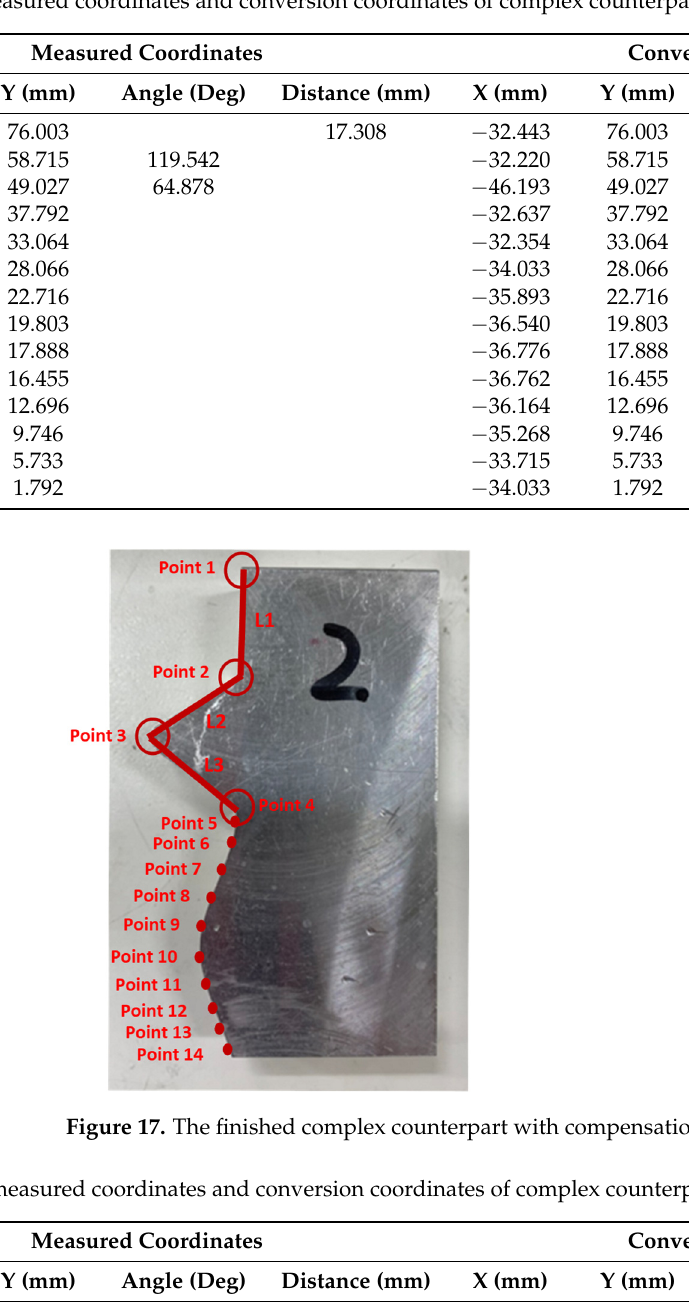
Table 6. The measured coordinates and conversion coordinates of complex counterpart without compensation.